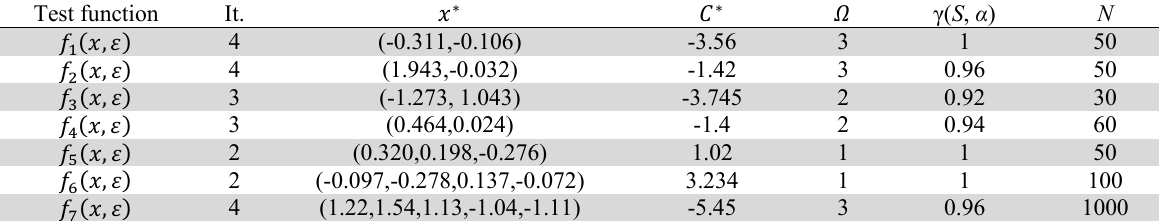
Results of the second method for the test functions